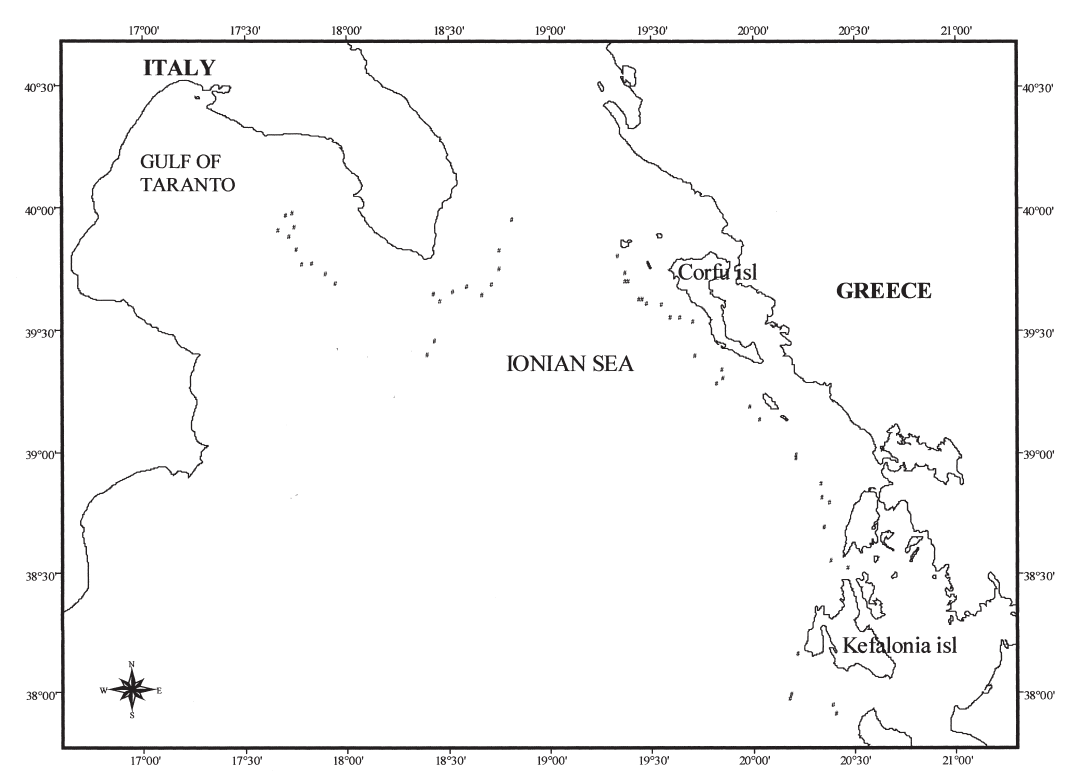
DIET OF PARAPENAEUS LONGIROSTRIS